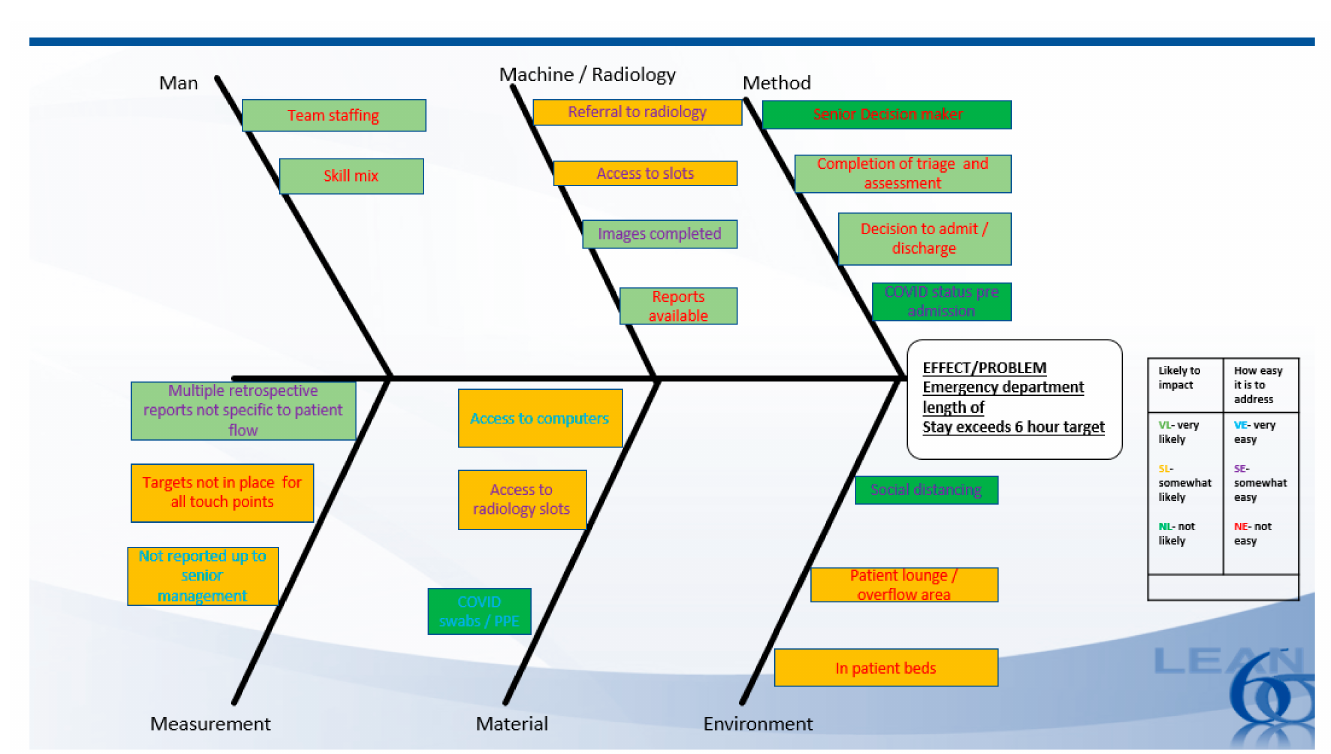
Figure 3. Fishbone cause-effect